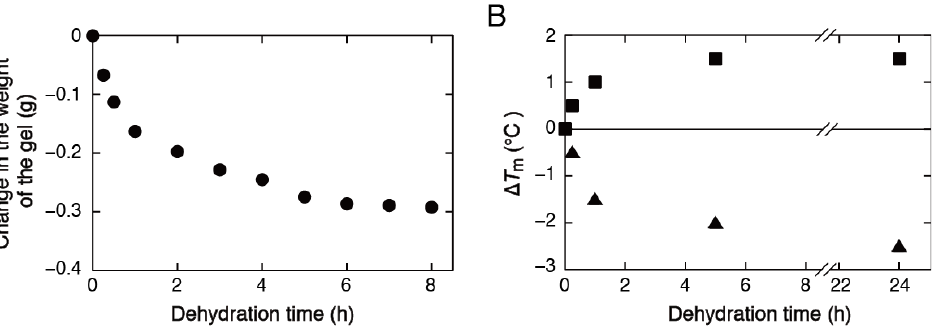
Figure 5. ( A ) Changes in the weight of a 10% polyacrylamide gel by dehydration using a high-os- motic pressure solution. ( B ) Changes in the T m values of 10-mer HP (triangles) and 21-mer GQ (squares) in the gels prepared by osmotic dehydration at different time points, compared with the T m in the solution.